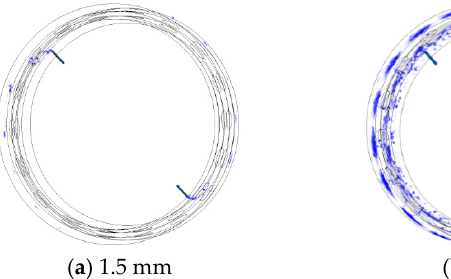
Processes 2020 , 8 , x FOR PEER REVIEW Figure 9. Oil distribution inside ball bearing with different aperture diameters. Figure 9. Oil distribution inside ball bearing with di ff erent aperture diameters.